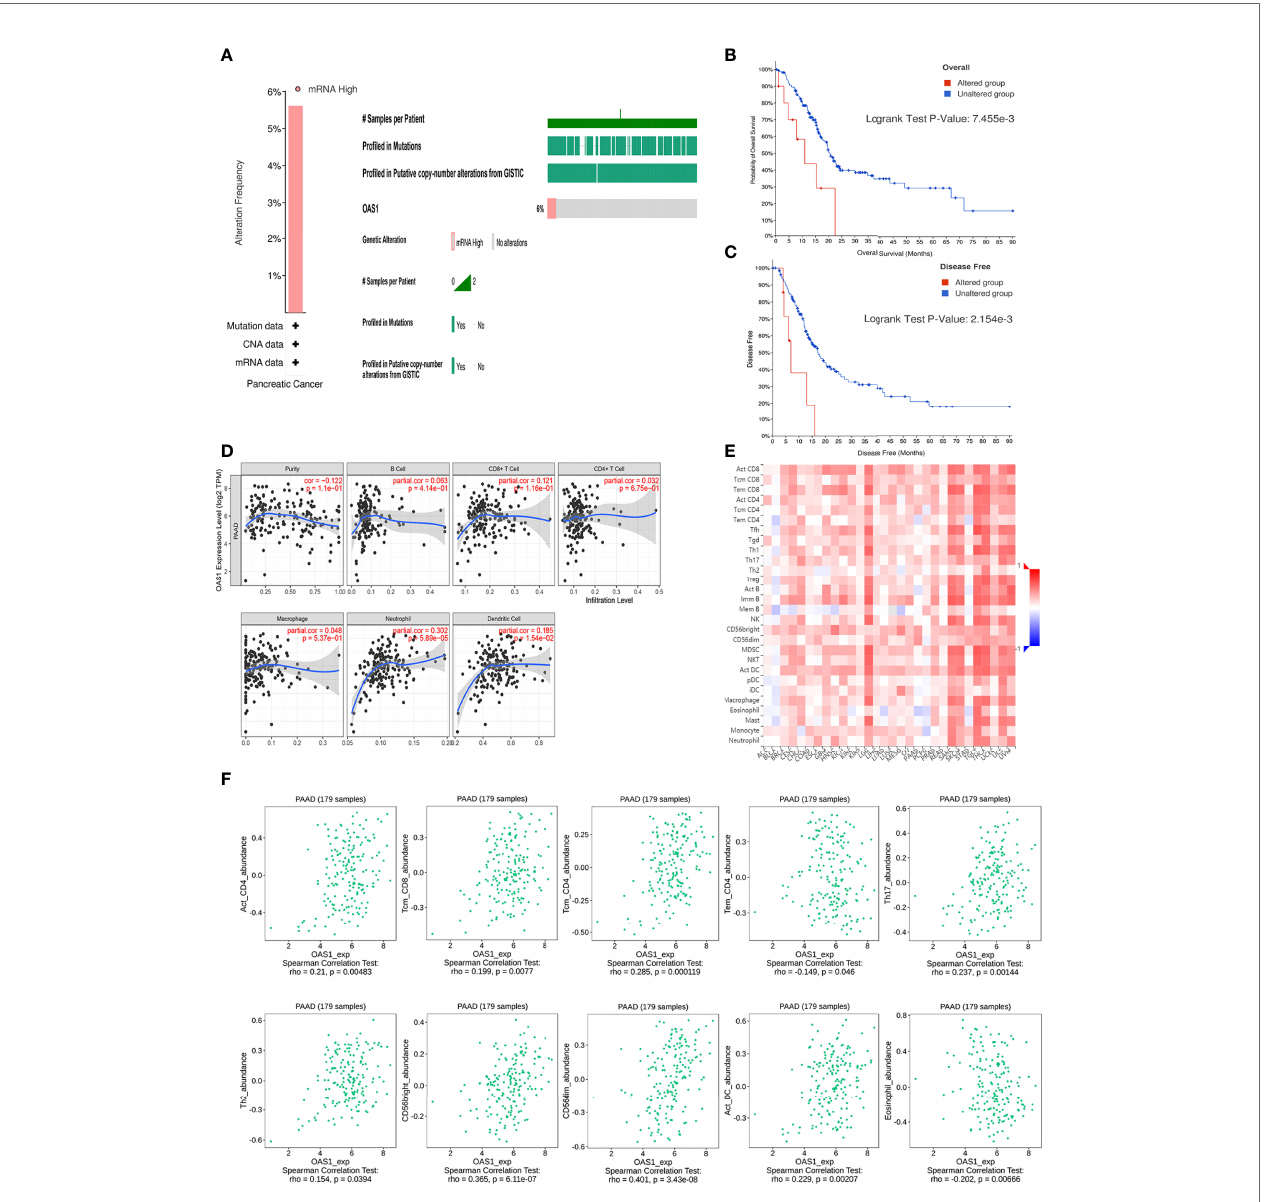
FIGURE 3 | Genetic alterations and immune in fi ltration. (A) Genetic alterations of OAS1 in patients with pancreatic cancer. The patient of altered group received a shorter OS (B) and DFS (C) than that of unaltered group. (D) OAS1 expression had correlations with neutrophil and dendritic cell. (E) correlations of OAS1 expression with TILs across human cancers. (F) The expression of OAS1 was associated with activated CD4 T cell, central memory CD8 T cell, central memory CD4 T cell, effector memory CD4 T cell, Type 17 T helper cell, Type 2 T helper cell, CD56bright natural killer cell, CD56dim natural killer cell, activated dendritic cell, and